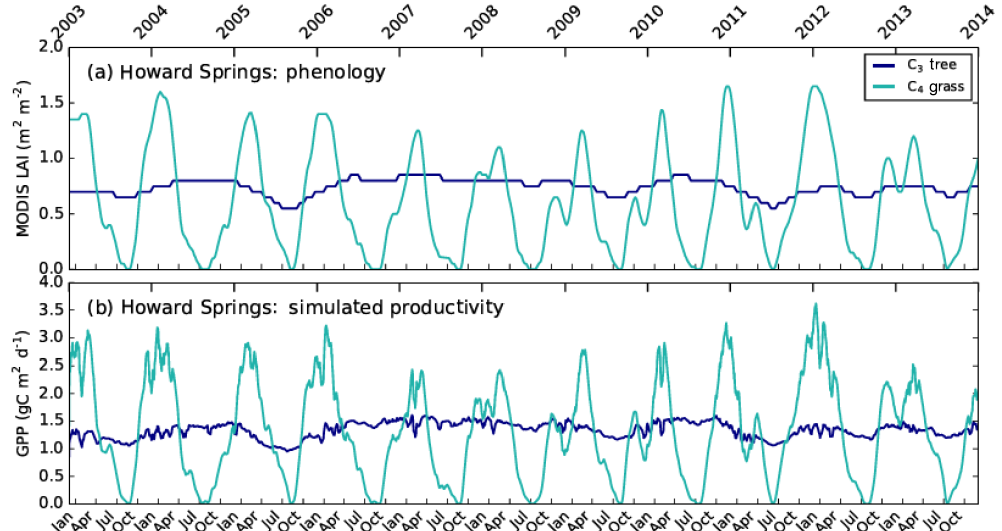
Figure 3. Representation of how changes to (a) tree and grass phenology determines changes in (b) savanna gross primary productivity (GPP) for an Australian mesic savanna. Time-varying signals of tree and grass LAI (a) are determined from a MODIS bulk LAI product using the method of Donohue et al. (2009) and are prescribed as inputs to the soil–plant–atmosphere (SPA) model to predict separate tree and grass GPP. Data and model outputs are from Whitley et al.